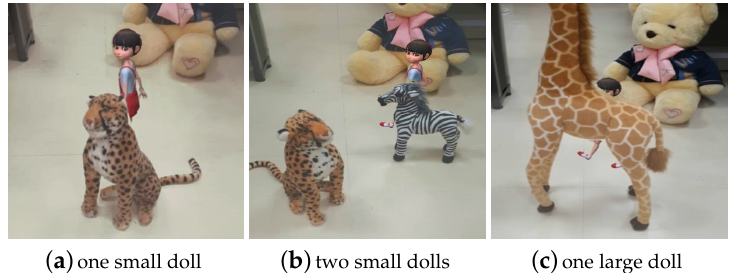
Figure 10. Photo illustrations of interaction scenarios with the silhouette meshes applied. ( a ) One doll that is similar in size to a virtual human, ( b ) two dolls that are similar in size to a virtual human, and ( c ) one doll that is larger than a virtual